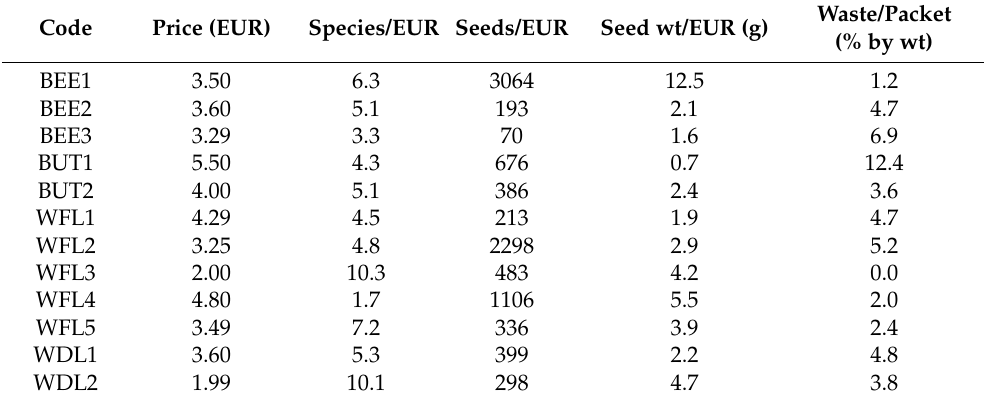
Table 2. Summary of value-for-money measures for 12 mixed wildflower seed mixes purchased in Ireland in 2022. Price is per packet at time and place of purchase (see Table 1).